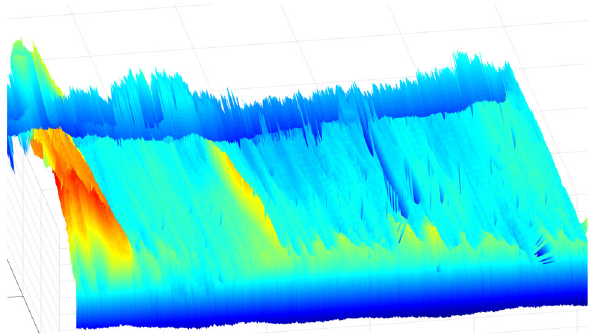
Fig. 12 Raw radar data with range estimate and maximum echo